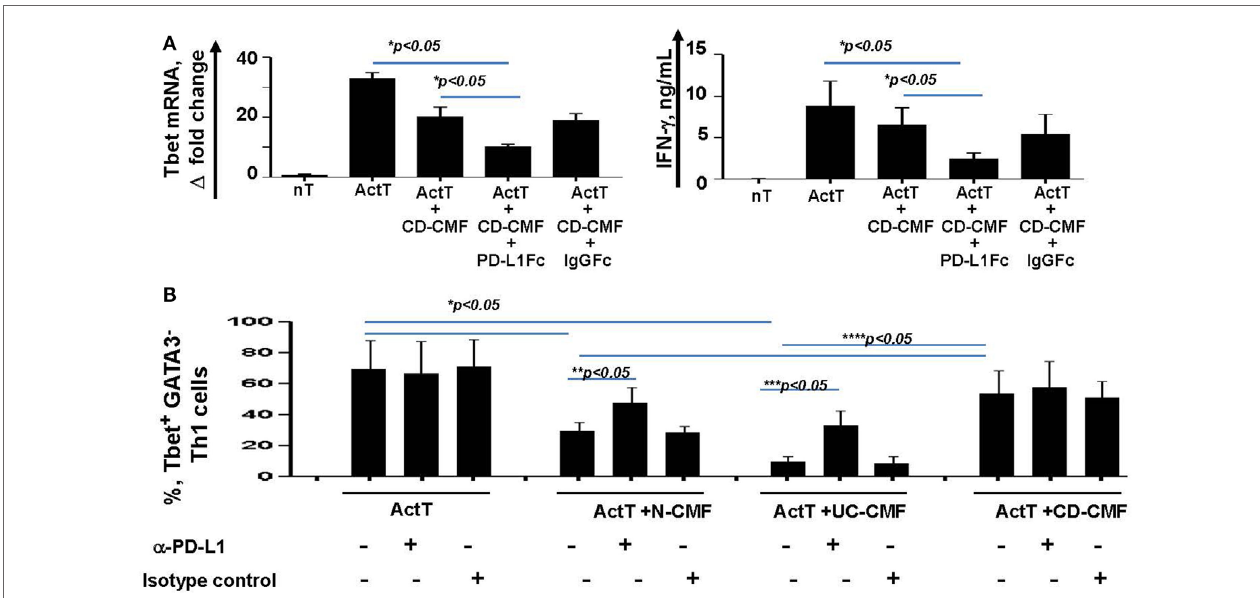
FigUre 8 | (a) CD-CMFs were cocultured with allogeneic CD3/CD28-preactivated naive CD4 + T cells in presence/absence of the PD-L1Fc or IgG Fc control. IFN- γ expression (real-time RT-PCR) and secretion (singleplex cytokine analysis) were analyzed. The means ± SEM are shown, n = 3 allogeneic donor pairs per group, two experimental replicates each. (B) Th1 cells were differentiated from CD4 + naïve T cells and cocultured with N-, UC-, and CD-CMFs in presence/absence of the PD-L1 blocking monoclonal antibodies or isotype control. Percentage of the T cells expressing the Th1 transcription factor Tbet was analyzed by flow cytometry. The means ± SED are shown, n = 7 allogeneic donor pairs per